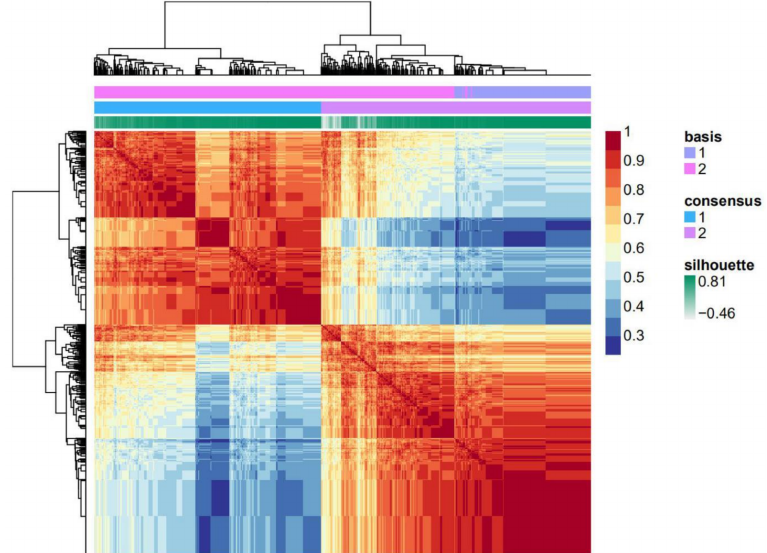
Figure 2. The heatmap of correlation coe ffi cient is clustered by non-negative matrix factorization (NMF). The final clustering generated two groups. One is the rectangle in the upper-left and the other is the rectangle in the lower-right which were named as HAM1 and HAM2, respectively. Each point in the heatmap represents the correlation coe ffi cient between two samples, as displayed by color scale. Three annotation tracks that contributed to the clustering were displayed above the heatmap, including basis components, consensus and silhouette width. Except for the consensus which represents the consistency in the 30 times running of NMF clustering, both the ‘basis component’ and ‘silhouette’ tracks are analyzed in more detail in the following